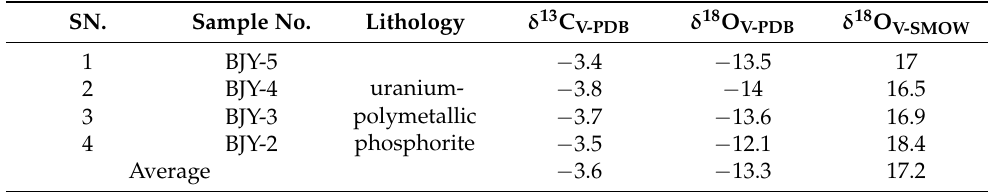
Table 3. The C, O isotopic characteristics of the uranium-polymetallic phosphorite samples collected from the Baizhuyu deposit (w B /‰).